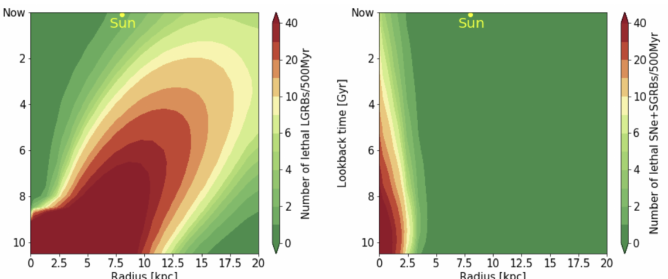
Figure 6. Galactic distribution (as a function of the galacticentric radius and lookback time) of the number of lethal LGRBs ( left ) and combined SGRBs and SNe ( right ). The color coding refers to the vertical bar representing, at a linear scale, the number of events per bin of 0.5